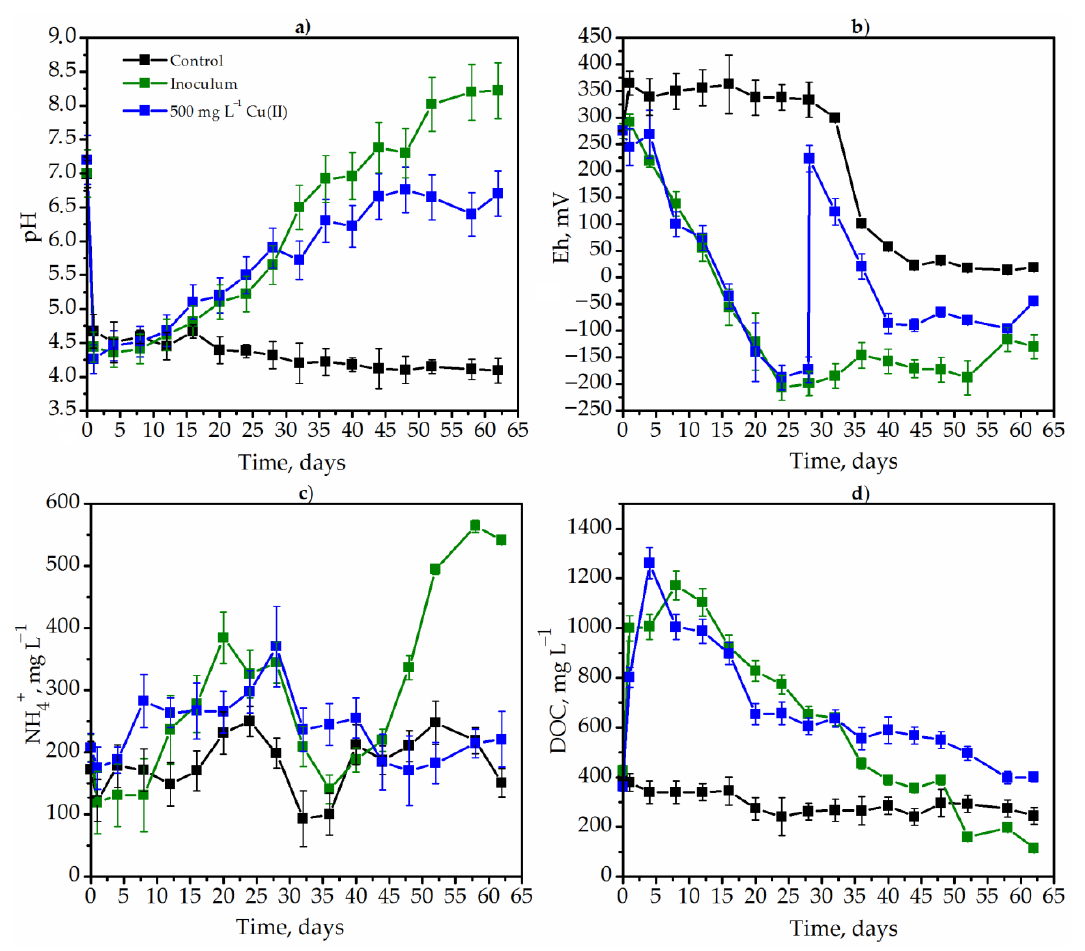
Figure 3. The dynamics of Solidago canadensis L. metabolic parameters pH ( a ), Eh ( b ), NH 4 − ( c ) and DOC ( d ) in different experimental conditions: the degradation by native microbiome (control without metals and additional inoculum) (black lines); the degradation by methane-producing and sulfate-reducing bacteria (green lines); the degradation at the presence of 500 mg L −1 Cu(II) (blue lines). The pH decreased sharply as a result of the synthesis of acidic exometabolites by the native microbiome of goldenrod under control variant of the experiment (Figure 3a, black lines). Thus, the pH value decreased from 6.99 to 4.7 in just one day. Subsequently, the pH of MPB and SRB adapted the pH to optimal values. In this case, the pH also decreased